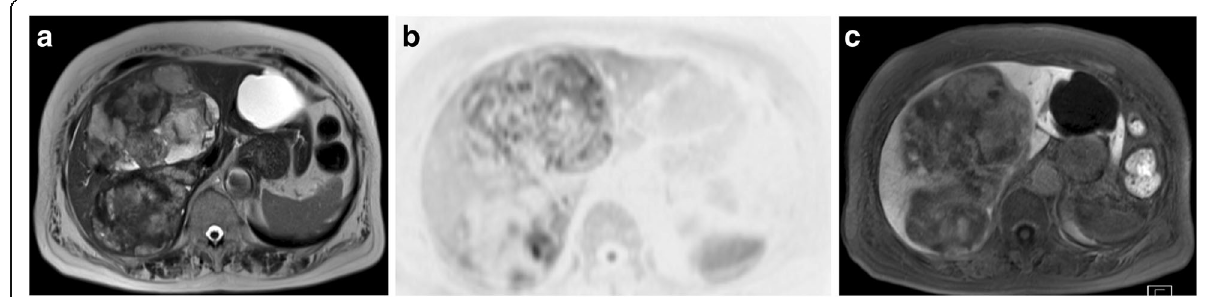
Fig. 2 Magnetic resonance imaging findings. a Magnetic resonance image showing a tumor with mixed high- and low-intensity signals on T2- weighted imaging (HASTE). b Diffusion-weighted image showing a high signal intensity of the tumor. c The dynamic 15-mm hepatobiliary phase image of the prolongation of the internal contrast effect